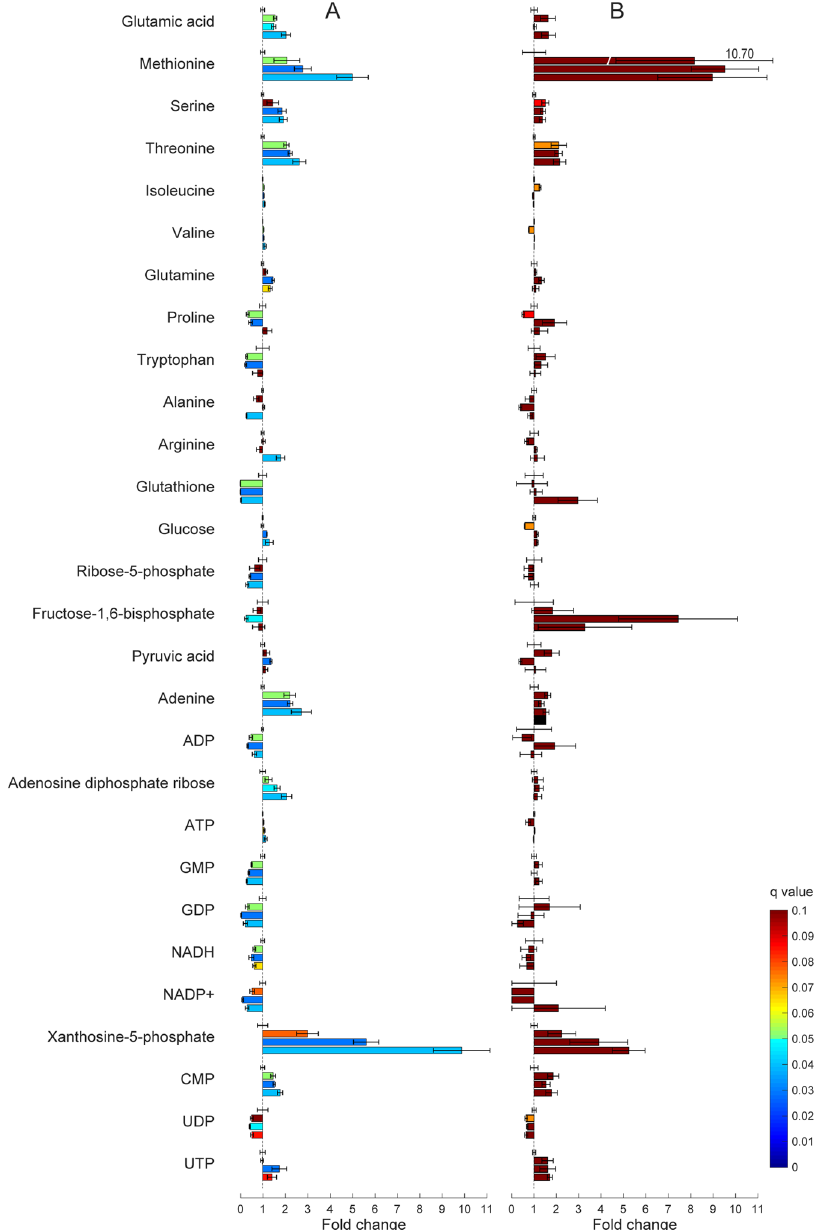
Figure 5. Metabolic changes in BAT and SWAT samples during cold exposure. Fold changes (compared to thermoneutrality; mean ± standard error, n = 6 mice) in selected metabolite levels in BAT ( A ) and SWAT ( B ) samples collected at 0, 2, 4, and 6 hours. For each metabolite 4 bars are shown: the top bar represents thermoneutrality (always shown at 1 ± standard error), and the others (top to bottom) indicate 2, 4 and 6 hours cold-exposure fold change vs thermoneutrality. Statistical significance was calculated by non-parametric Wilcoxon signed-rank tests with FDR. Bars are colored according to